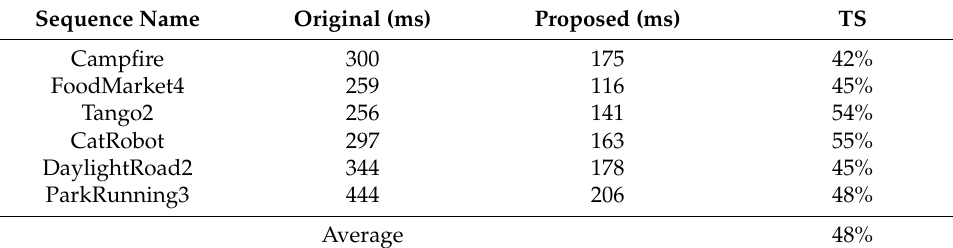
Table 7. Comparison of the extraction times for VP9 bitstreams.